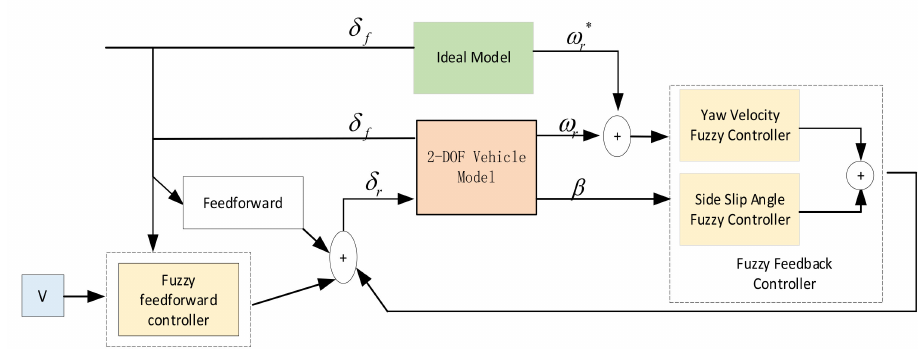
Figure 9. Collaborative controller.